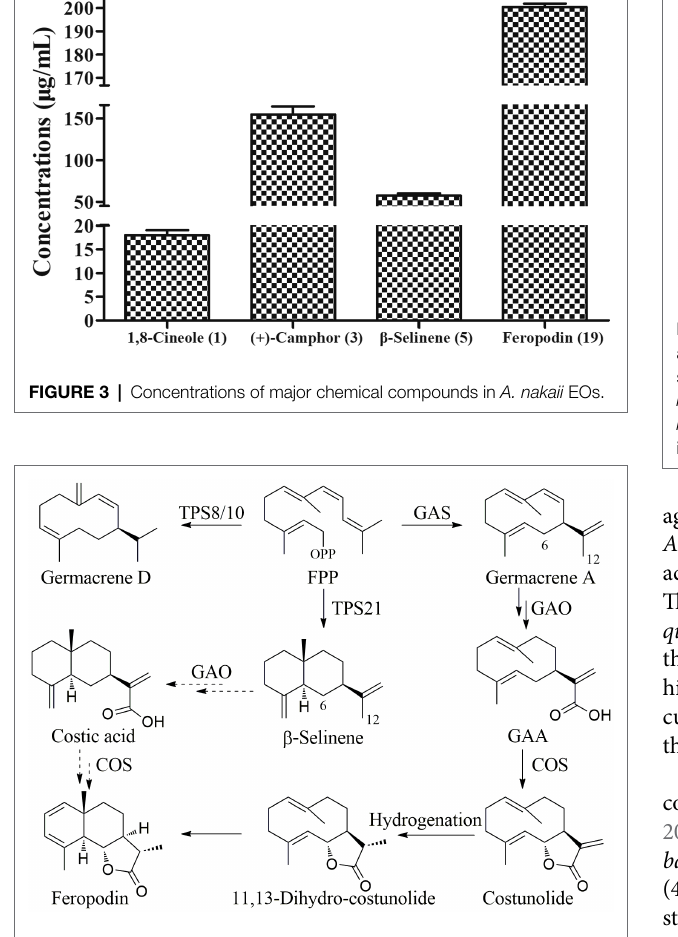
FIGURE 4 | Proposed biosynthetic pathway of sesquiterpenes in the EOs of A. nakaii .